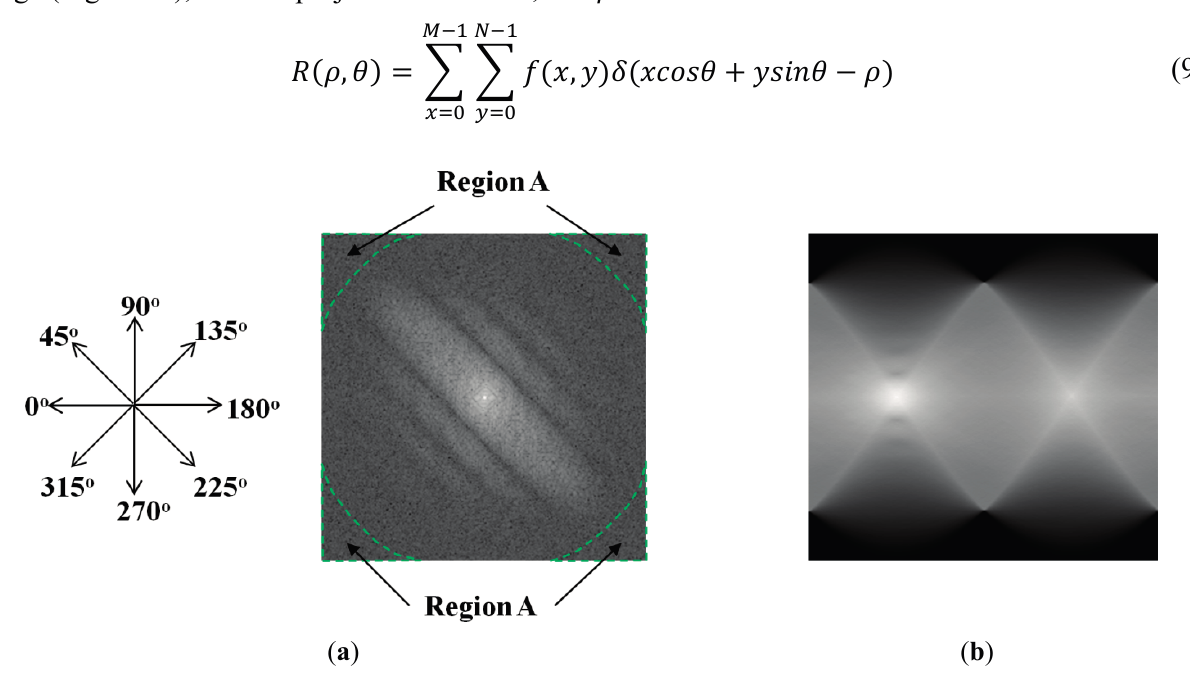
Figure 6. Example of Radon transform method: ( a ) input power-spectrum image; ( b ) Radon image in all directions (horizontal and vertical axes are (cid:2016) and (cid:2025) of Equation